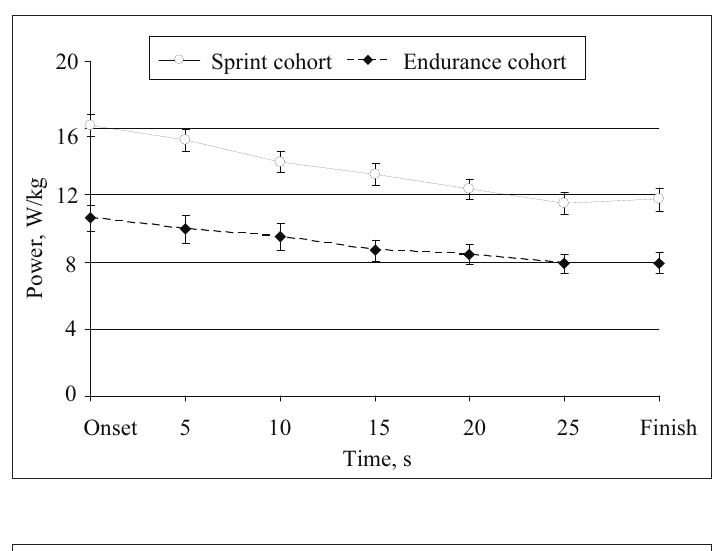
Figure 3. Duration of take‑off while performing 30‑s duration jump